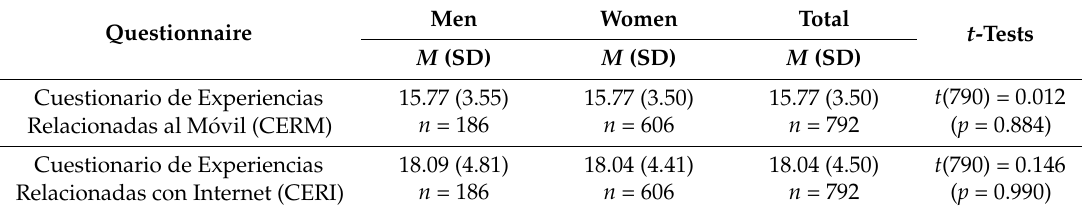
Table 2. Means and standard deviations of the Cuestionario de Experiencias Relacionadas con Internet (CERI) and the Cuestionario de Experiencias Relacionadas al M ó vil (CERM) scores for cohort